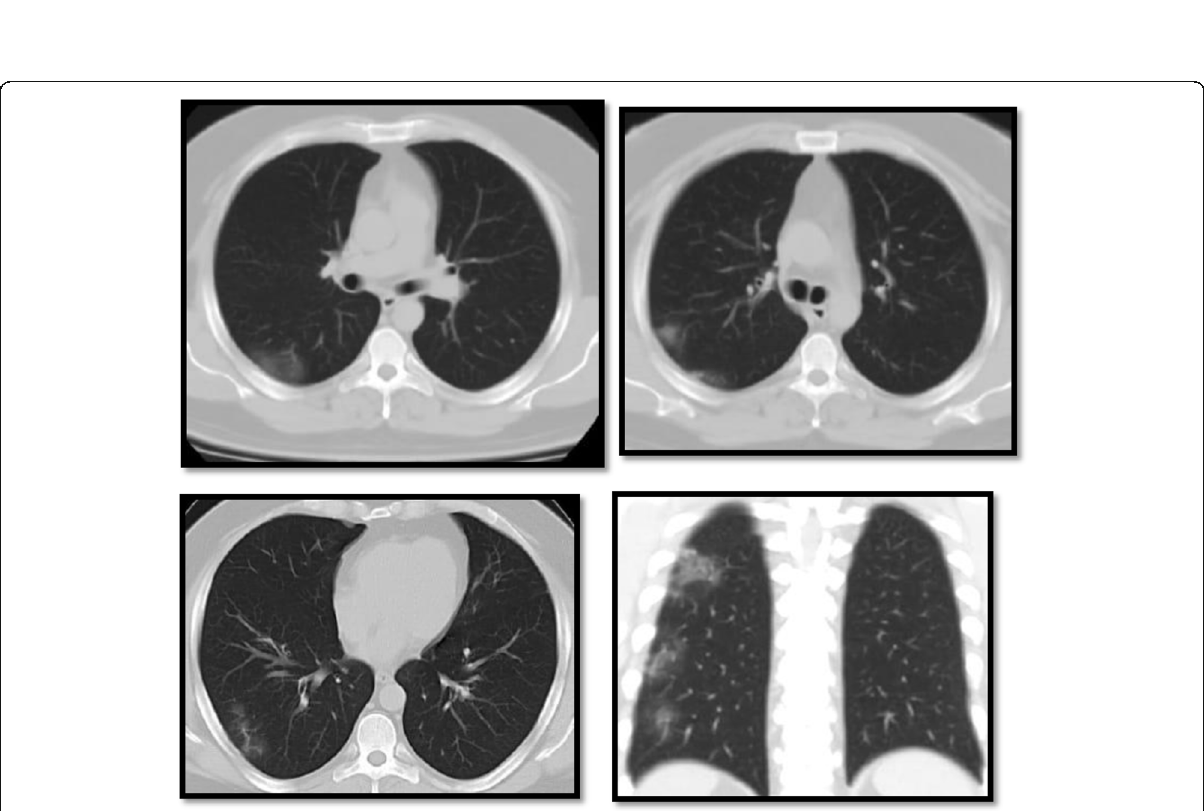
Fig. 3 A female patient, 37 years old, resented with fever and cough. MSCT of the chest was done showing typical peripheral distribution of the ground-glass opacities seen in COVID positive